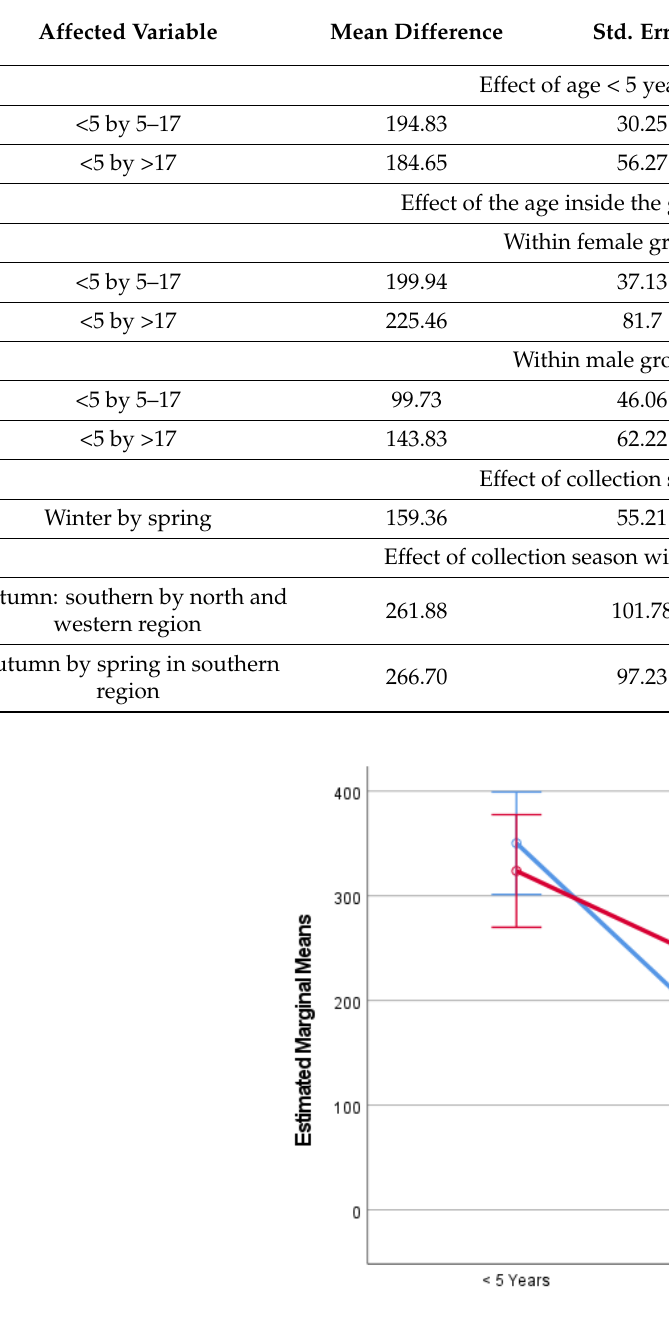
Table 3. Comparison of factors affecting the strongyle egg counts using a univariate general linear model. The factors that significantly affected the mean strongyle EPG (age and season) determined using a univariate general linear model.